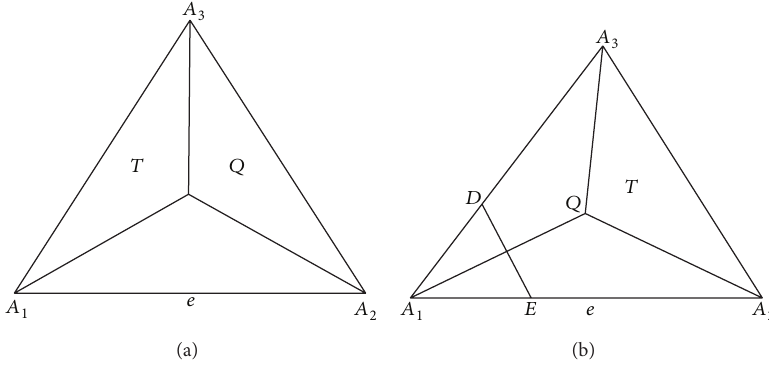
Figure 4: (a) K is a noninterface element and (b) K is an interface